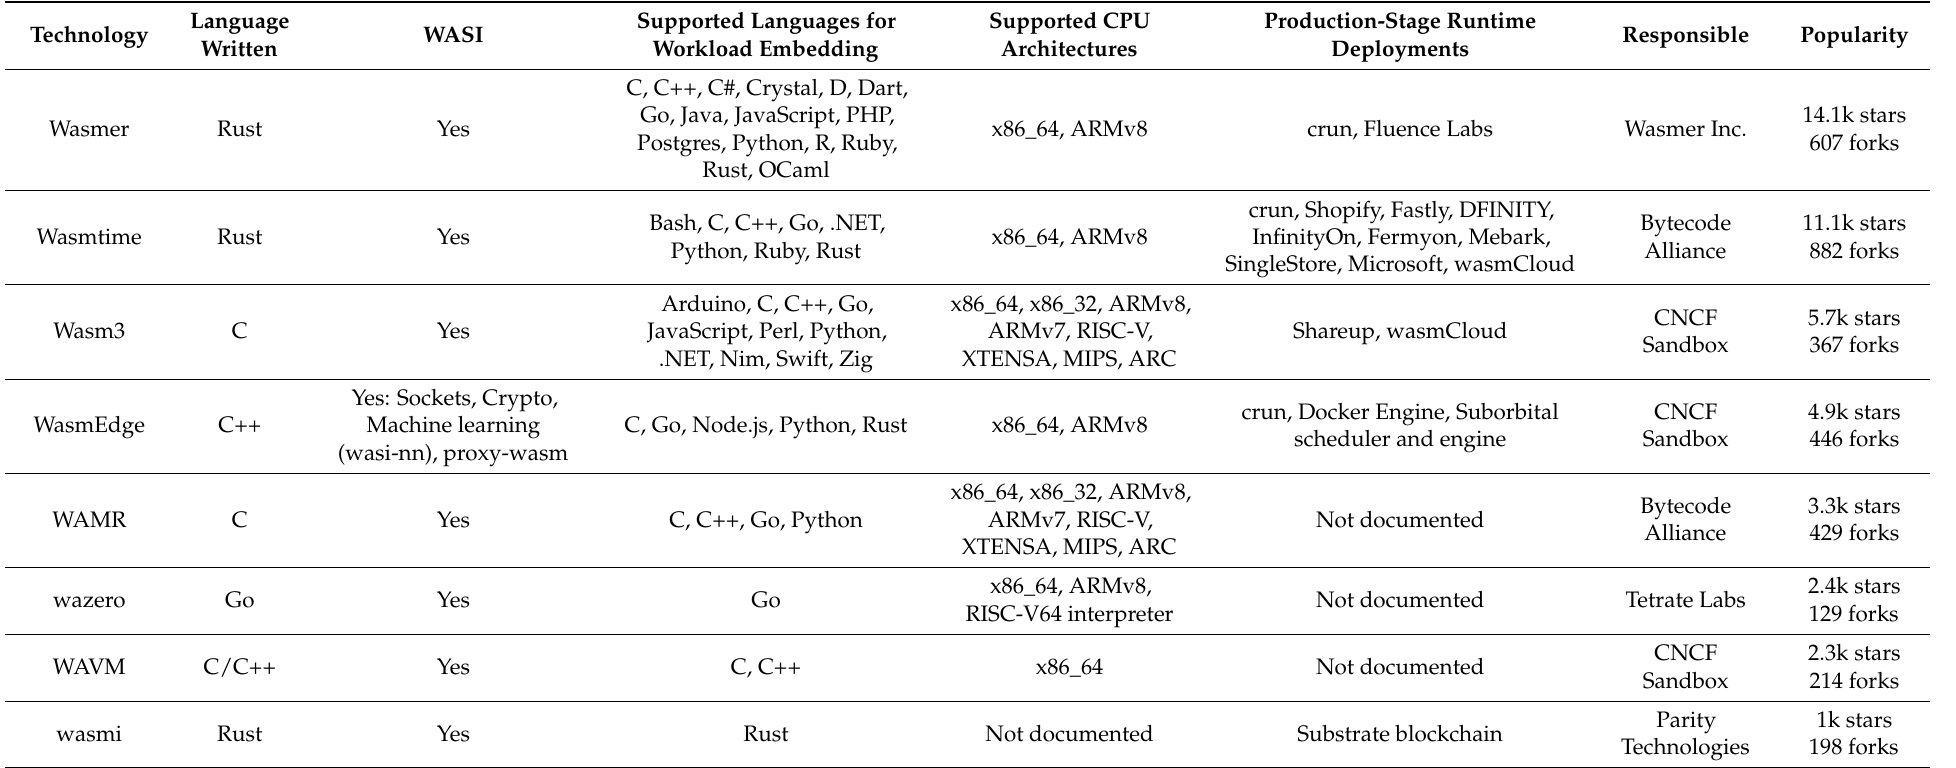
Table 2. Comparison of Wasm